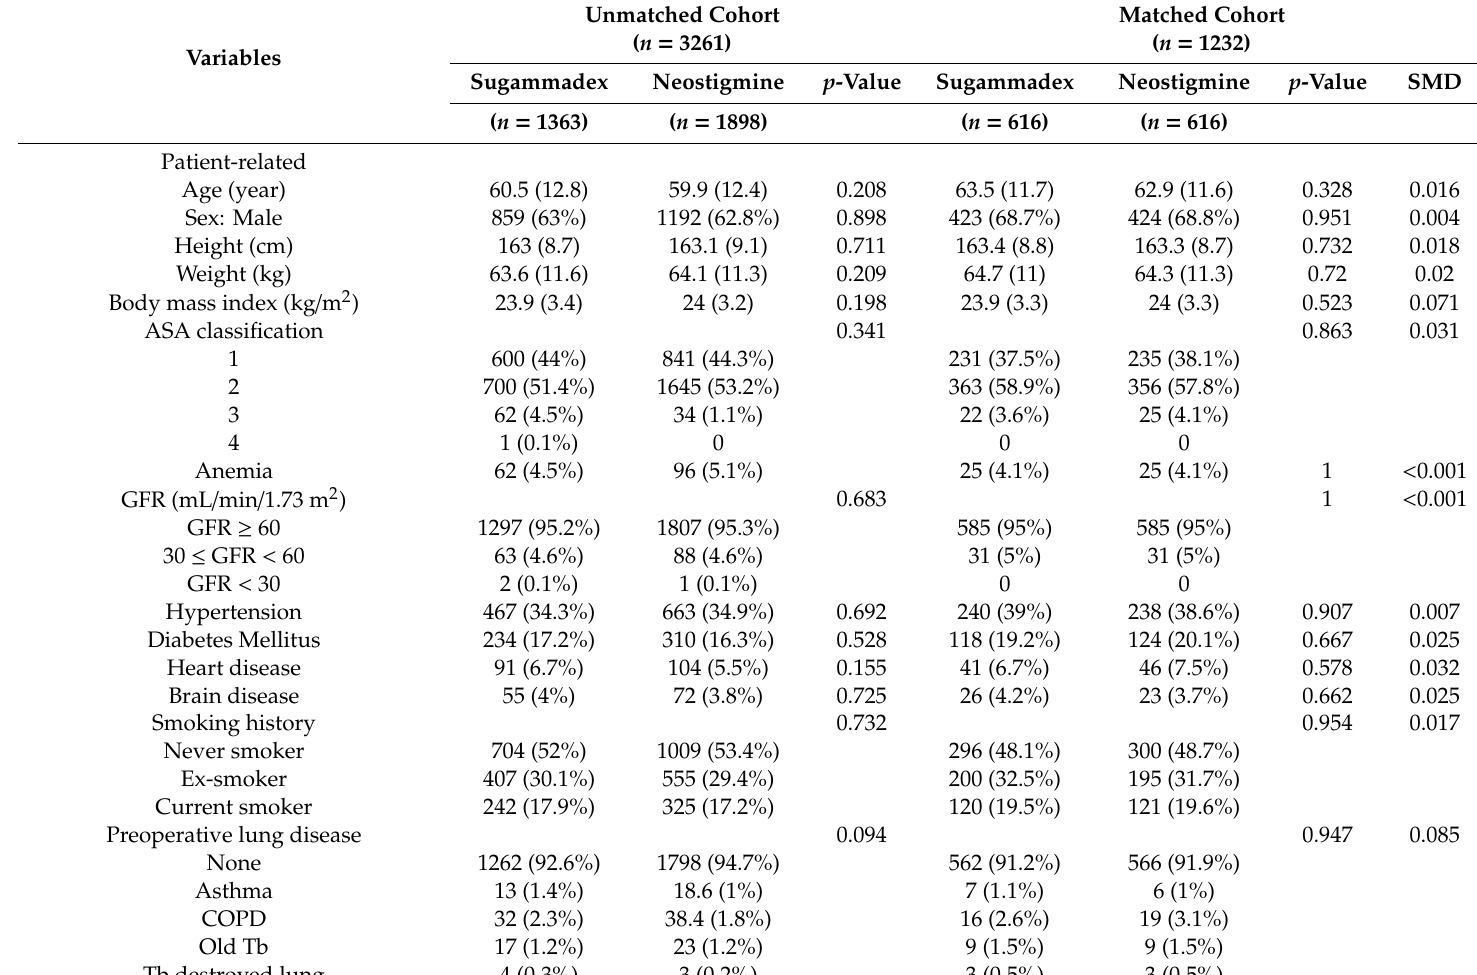
Table 2. Patient characteristics for unmatched cohort and propensity score-matched